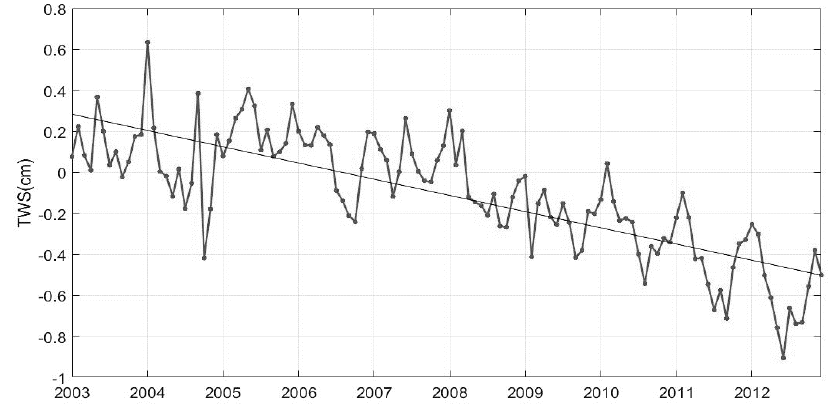
Figure 8. Time series of GRACE terrestrial water storage TWS (cm) from 2003 to 2012.